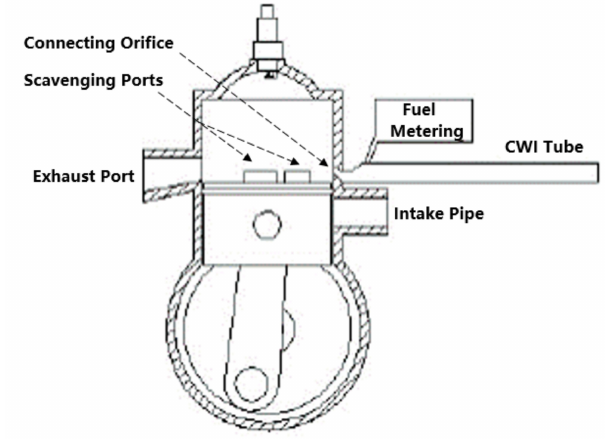
Figure 5. Schematic diagram of the reference engine